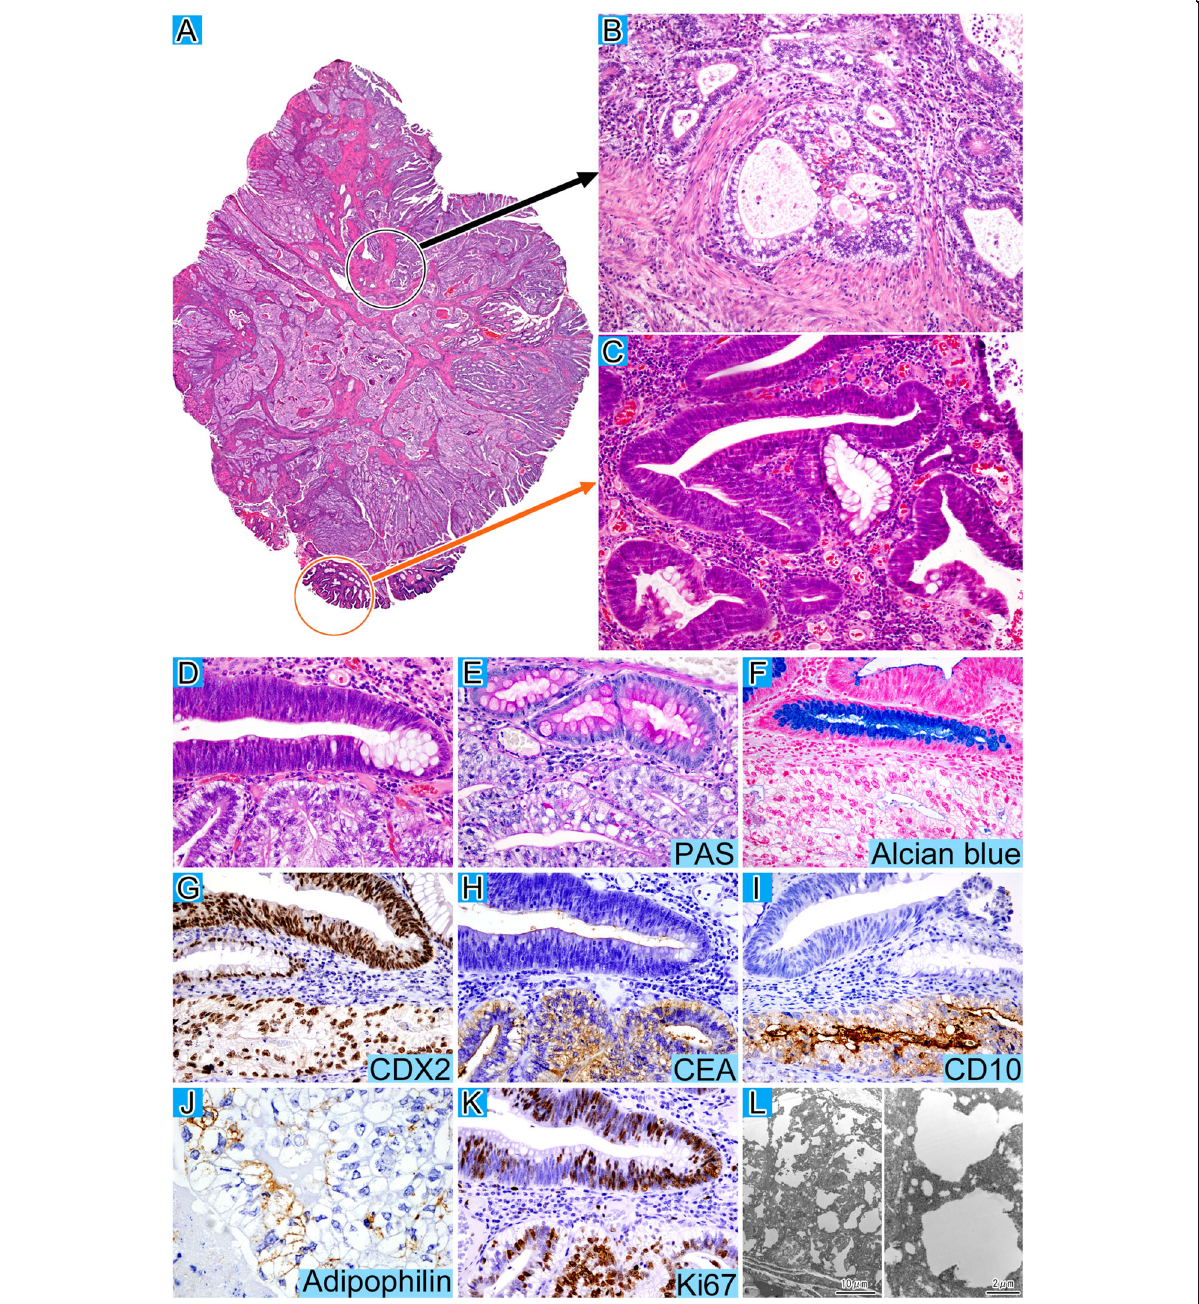
Fig. 2 Clear cell adenocarcinoma. Low magnification ( a ) and high magnification of the clear cell ( b ) and conventional components ( c ) with HE staining. The boundary ( d ) between the clear cell and conventional components at high magnification with HE staining. The clear cells are negative for PAS ( e ) and alcian blue staining ( f ), whereas both components of the tumor are positive for CDX2 ( g ). The localization of CEA ( h ) expression is diffusely cytoplasmic for the clear cell component and luminal cell apical for the conventional component. CD10 ( i ) and adipophilin ( j ) expression is confined to the clear component and Ki67 labeling ( k ) is higher in the clear cell component. g-k represent immunohistochemistry. Immunoelectron microscopy analysis ( l ) at low (left) and high magnification (right) reveals multiple cytoplasmic lipid-like vacuoles in clear cells that are negative for